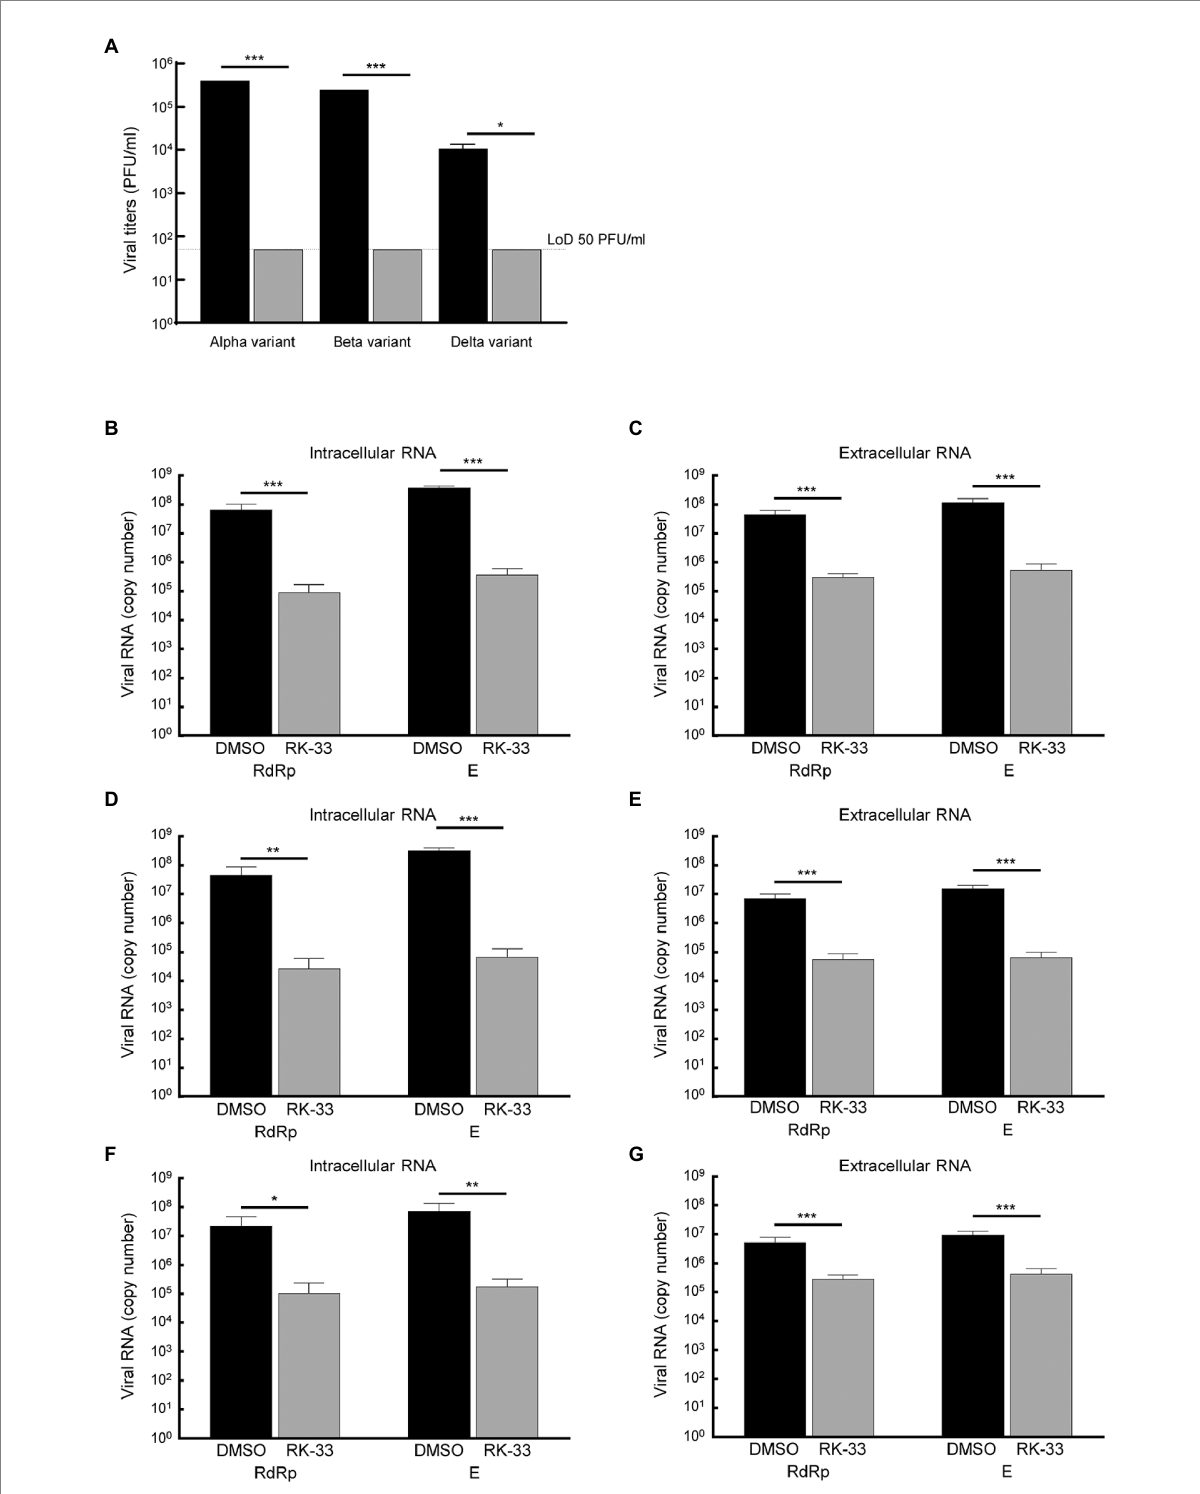
FIGURE 5 (A) Calu-3 cells were treated with RK-33 (5uM) for 24 h followed by infection with Alpha, Beta, and Delta variants of SARS-CoV-2. Supernatants were collected at 48 hpi and plaque assays performed to determine infectious titers. DMSO was included as a negative control. (B) RNA was extracted from SARS-CoV-2 Alpha variant-infected cells treated with RK-33 and subjected to RT-qPCR in a one-step protocol that amplified RdRp and E genes. Copy numbers were calculated from known positive controls. (C) Extracellular RNA was extracted from above cell supernatants and processed as earlier. (D,E) Results from intra-and extracellular RNA from RK-33 treatment of Beta variant infection. (F,G) Results from intra and extracellular RNA from RK-33 treatment of Delta variant. * p < 0.05, ** p < 0.005, *** p <